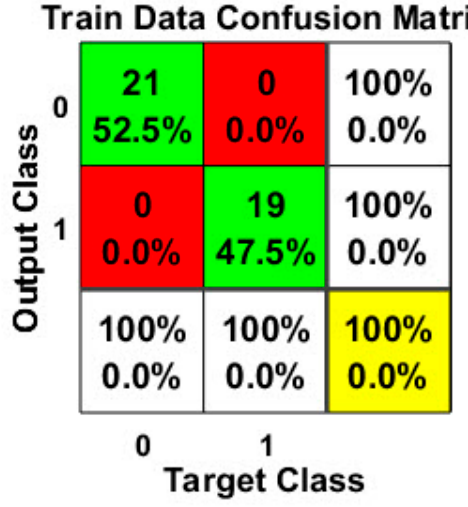
Figure 6. The results of confusion matrix for training data.